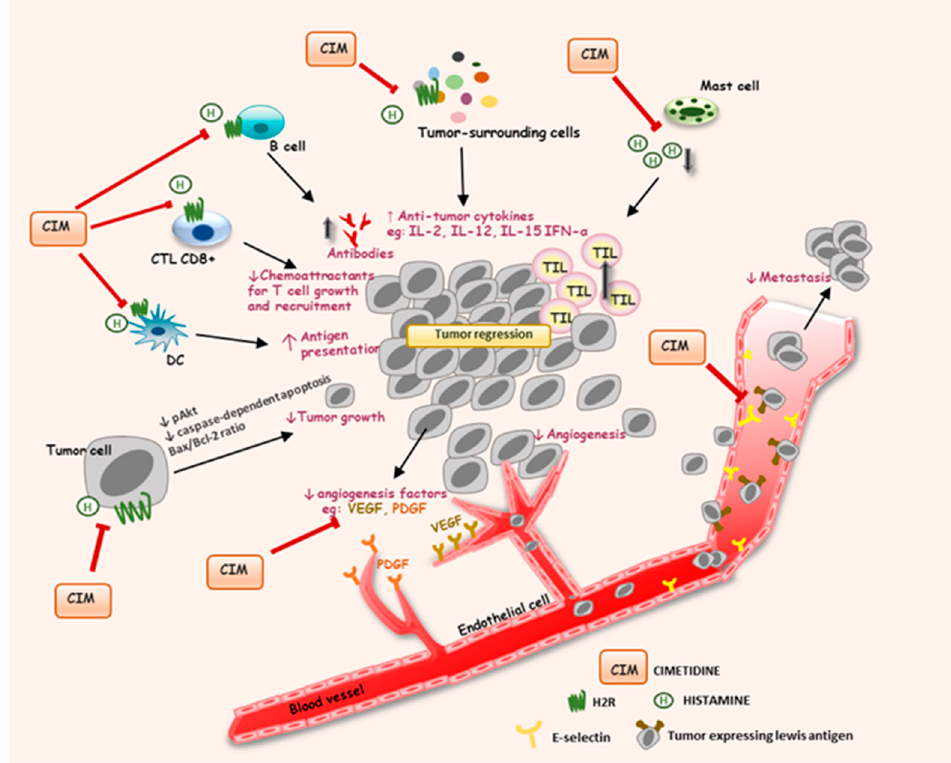
Figure 3. Potential action mechanisms underlying the antitumor effects of cimetidine. See the text for detailed mechanisms by which cimetidine exhibits antitumor activities in many different types of cancer. MC: mast cell; CTL CD8+: cytotoxic T lymphocyte; TILs: tumor-infiltrating lymphocytes; DC: dendritic cell; VEGF: vascular epithelial growth factor; PDGF: platelet-derived endothelial growth factor; H2R: histamine H2 receptor.